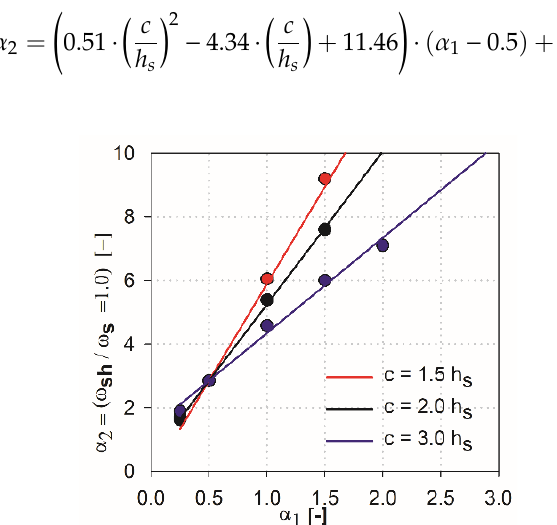
Figure 11. Summary of the analysis results—EC2.